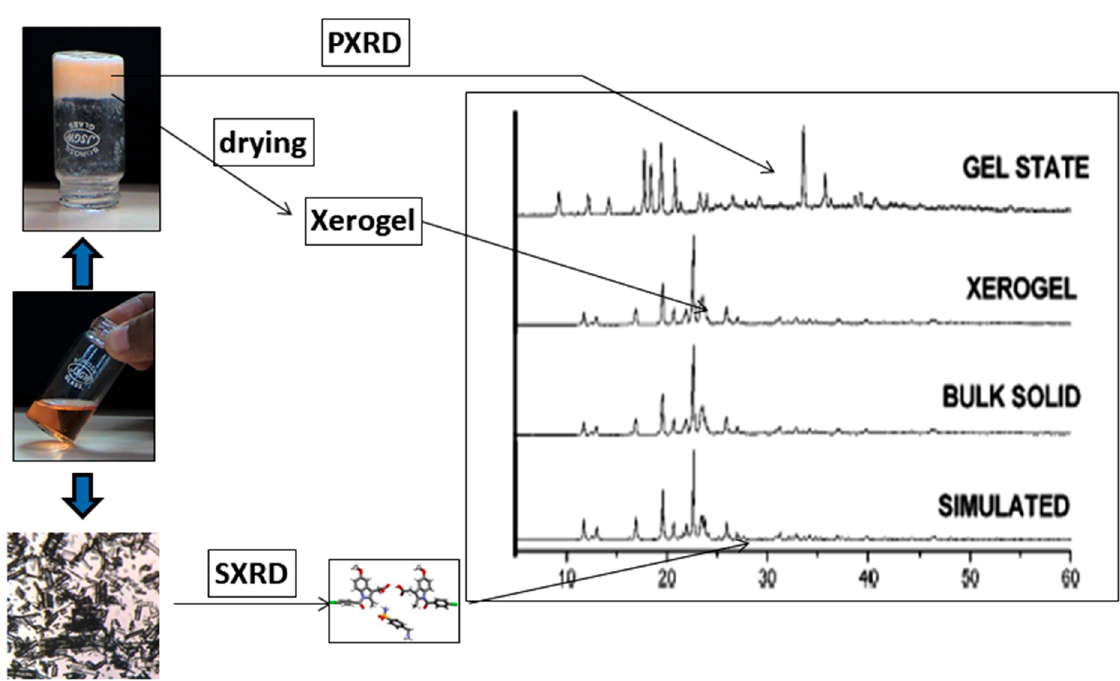
Scheme 2. Schematic representation of the methodology to determine the structure of self-assembled fibrillar network (SAFiN) (micrograph of the single crystals, crystal structure illustration, and powder X-ray diffraction (PXRD) patterns are a representative depiction and may not necessarily be related). (SXRD: single crystal X-ray diffraction).